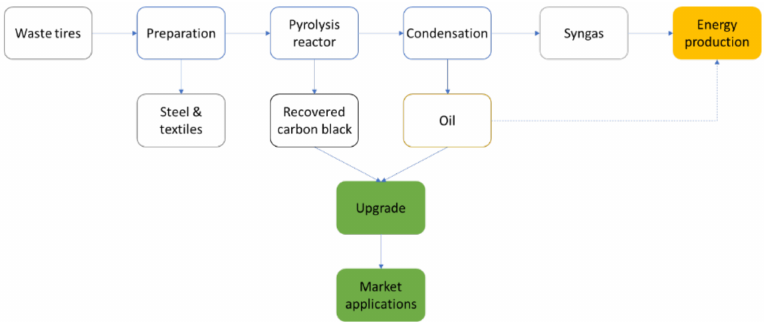
Figure 3. Pyrolysis process: from ELT to rCB, oil, and syngas, and applications